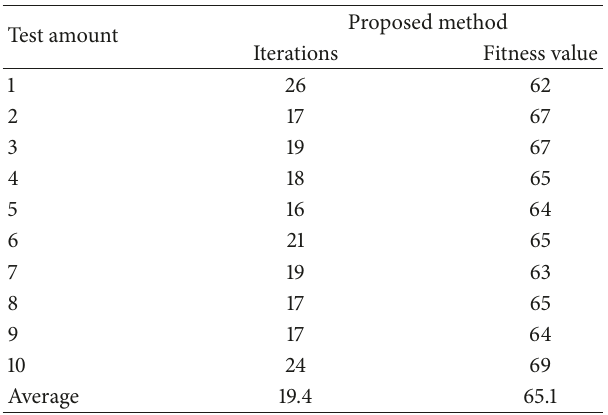
Table 3: Times and errors of outlier data feature state responses detected with the proposed method.